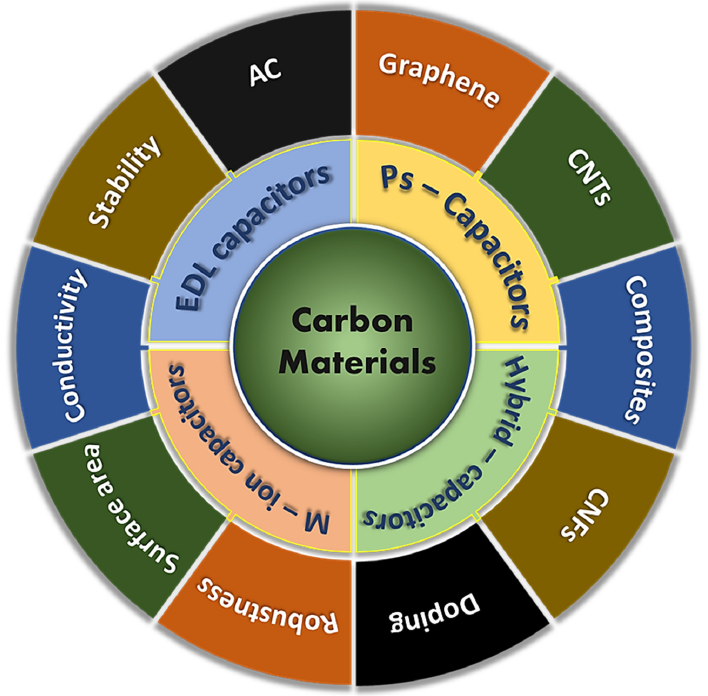
Figure 1. Graphical representation of carbon-based electrode materials and different types of capac- itive storage devices. tive storage